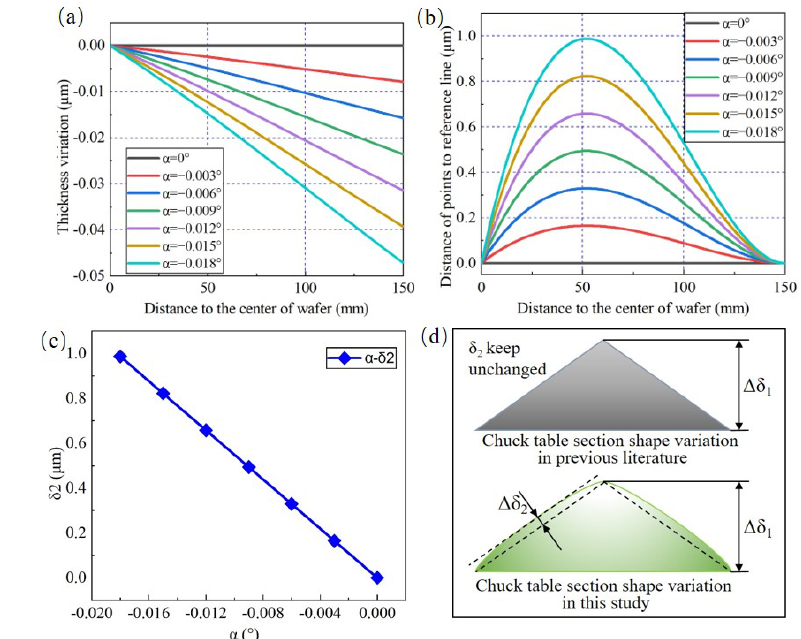
Figure 8. The change rules of δ 2 affected by space angles. Effect of ( a ) α on the thickness variation ( β = 0°); ( b ) α on the distance of points to the reference line ( β = 0°); ( c ) α on δ 2 . ( d ) The qualitative analysis and comparison: the change rules of TTV features when α varies between the previous literature and this